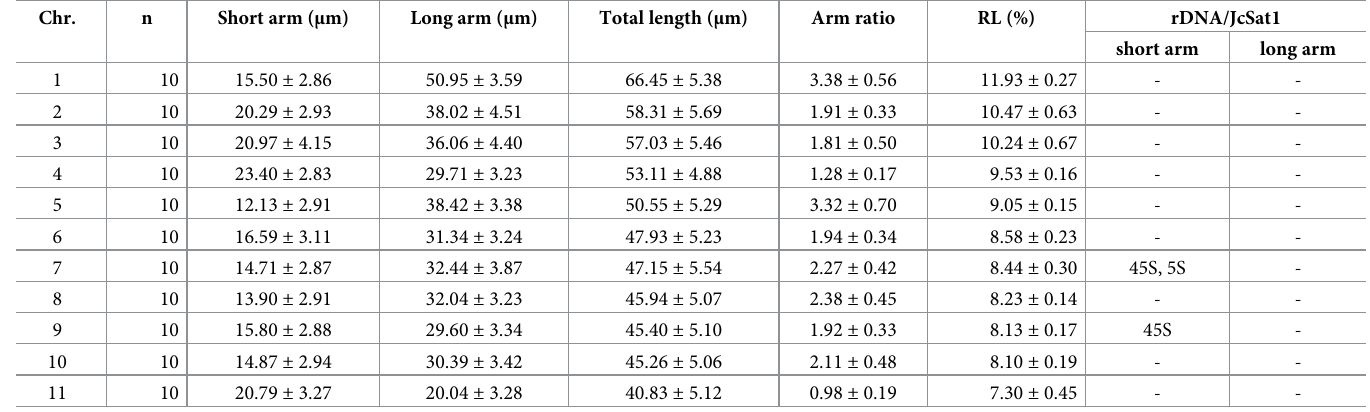
Table 2. Mean ± SD for morphometric and physical location of 45S rDNA and 5S rDNA on J . integerrima pachytene chromosomes.